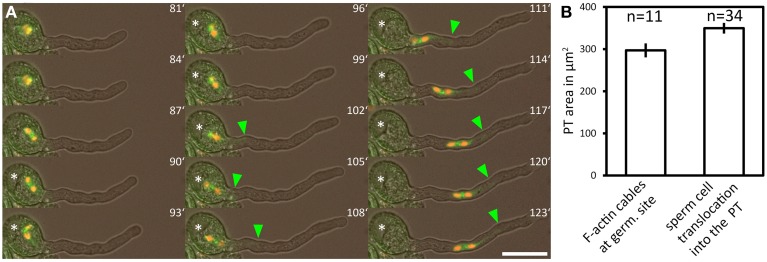
The male germ unit is transported into the PT after the transition to rapid tip growth. A marker line labeling both sperm nuclei (red fluorescence) and the sperm plasma membrane (green fluorescence) was used for time lapse imaging of pollen germination. (A) Green arrowhead points to the tip of the long sperm cell membrane extension physically associated to the vegetative cell nucleus, which has been transported into the pollen tube. Bar plots in (B) show average PT areas when F-actin bundles massively accumulate at the germination site (indication for rapid tip growth), compared to the mean PT area when the male germ unit is relocated into the PT. Scale bar in (A): 25 μm.